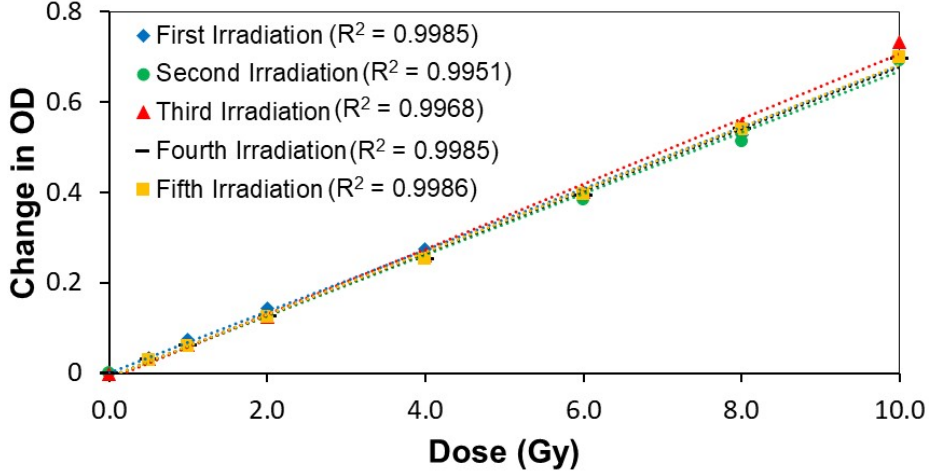
Figure 9. Five separate irradiations of Formulation 3 Group 2 with seven cuvettes ranging from 0.5–10 Gy dose. The reirradiations were performed well after the cuvettes had cleared back to a stable baseline OD following the previous irradiation. Least squares linear fits to each of the five data sets are shown above, with the R 2 coefficient included for each. Table 4. Formulation 3 (Groups 1 and 2) sensitivity measurements for five successive irradiations along with the percent change from the initial sensitivity.